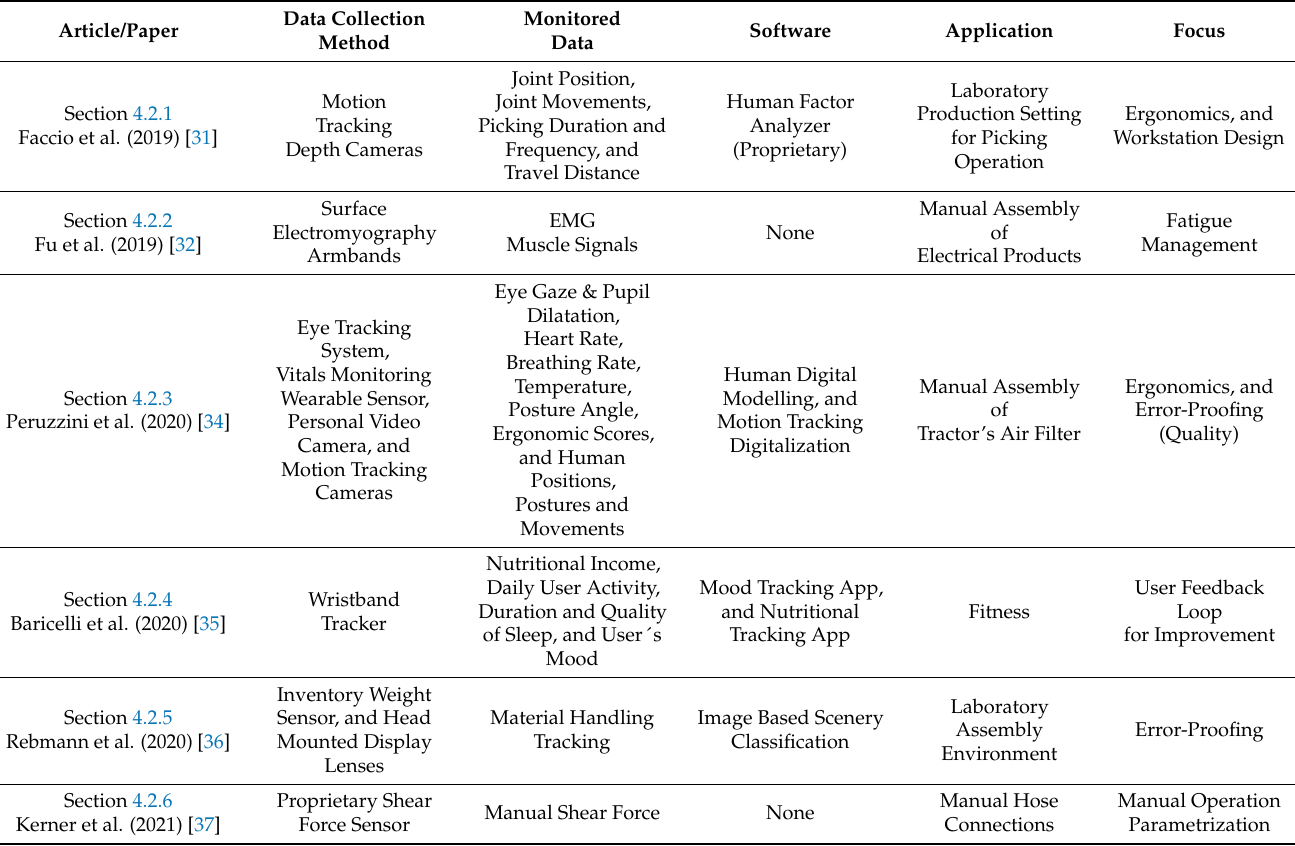
Table 5. Comparison of Domain 2—Reviewed journal articles and conference papers for data collection